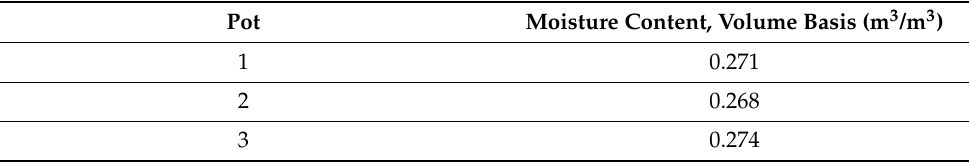
Table 4. Initial moisture content of the soil in the pot